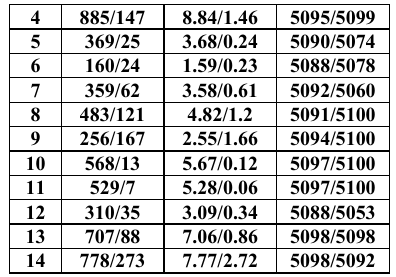
Table 1: Results of the adaptive Harris keypoint detection.